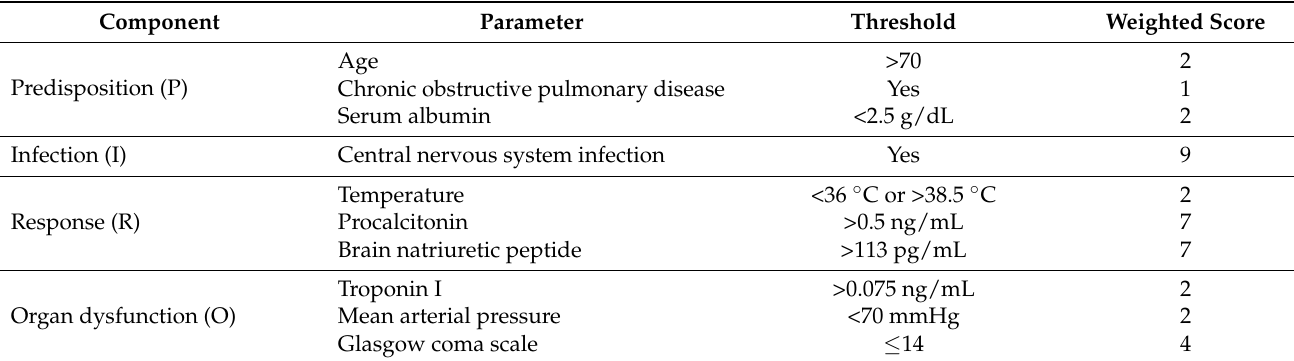
(Table 1) [127]. In a Danish population-based study in 1844 patients with community- acquired bacteremia, a single plasma albumin measurement on the date bacteremia was identified was a better predictor of short-term mortality than a sepsis severity score [38]. For each 0.1 g/dL decrease in serum albumin level, the odds ratio (95% confidence inter- vals) of mortality in the period of 0–30 days after bacteremia was 0.86 (0.84–0.88). In that study, the latest albumin measurement was taken 8–30 days before the date of bacteremia in 422 patients, and a higher proportion of patients died within 30 days if the albumin level decreased between days 8–30 prior to bacteremia and the eventual date bacteremia was identified [38]. Table 1. Score value of the ‘predisposition, infection/insult, response, and organ dysfunction’ (PIRO) staging system for community-acquired sepsis in the emergency department. Adapted from Chen and Li 2013